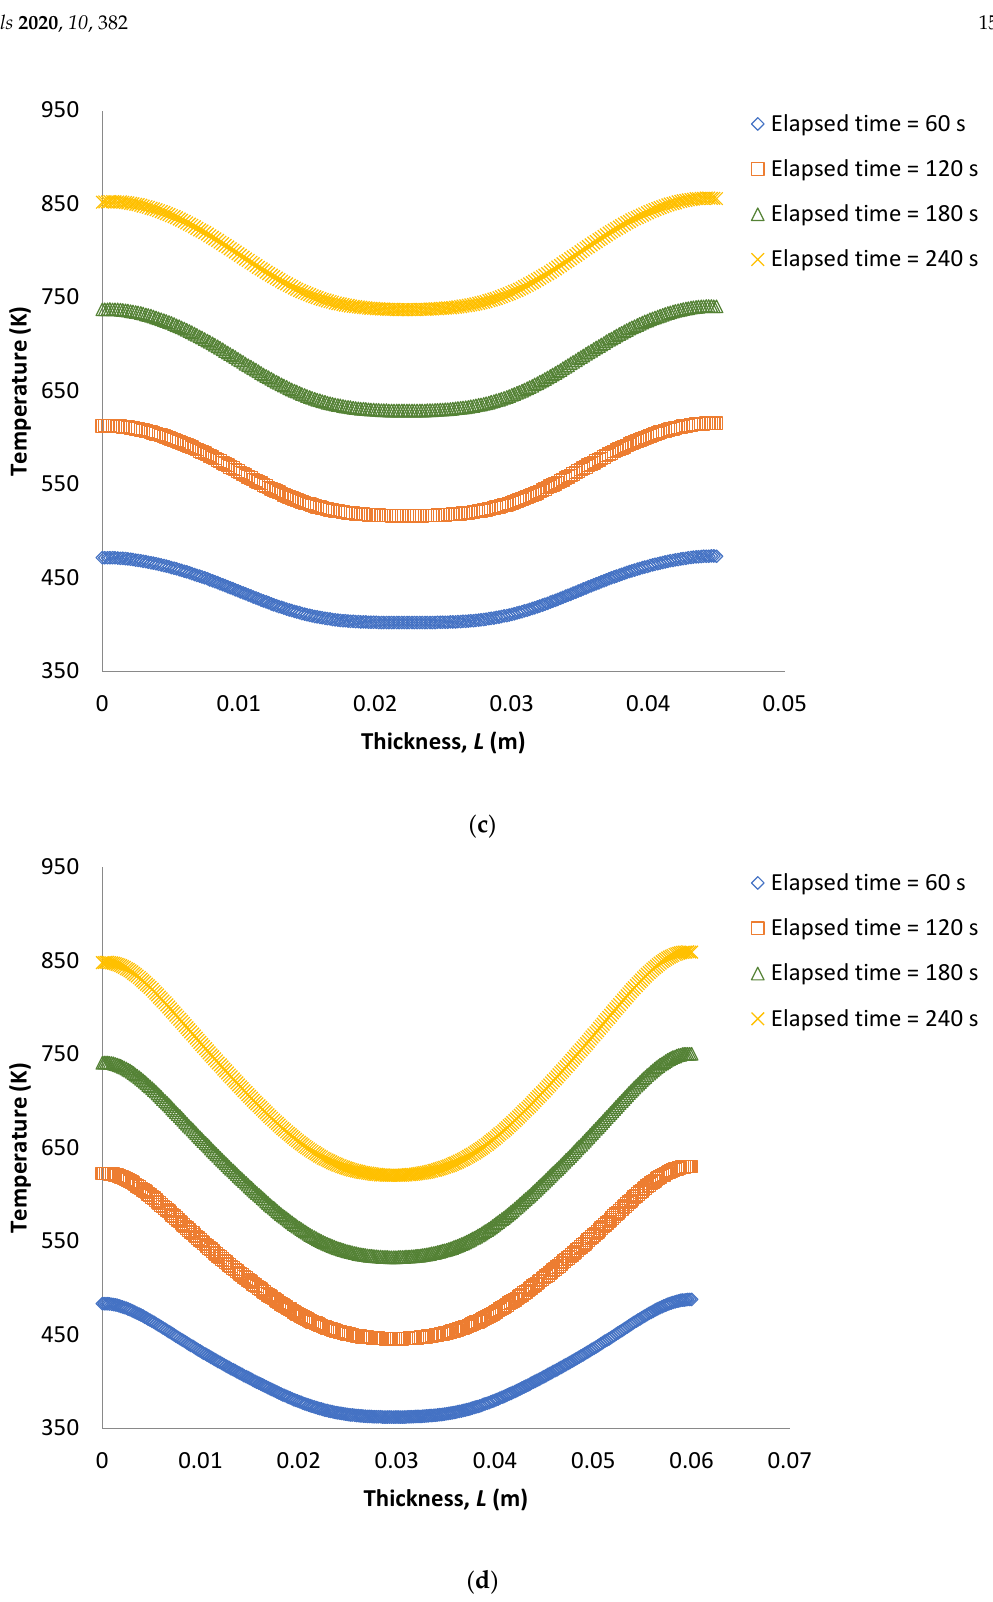
Figure A1. Temperature profiles along the center line of cylindrical ilmenite with respect to the variation of microwave heating times for different thickness: ( a ) L = 0.015 m; ( b ) L = 0.03 m; ( c ) L = 0.045 m; ( d ) L = 0.06 m.